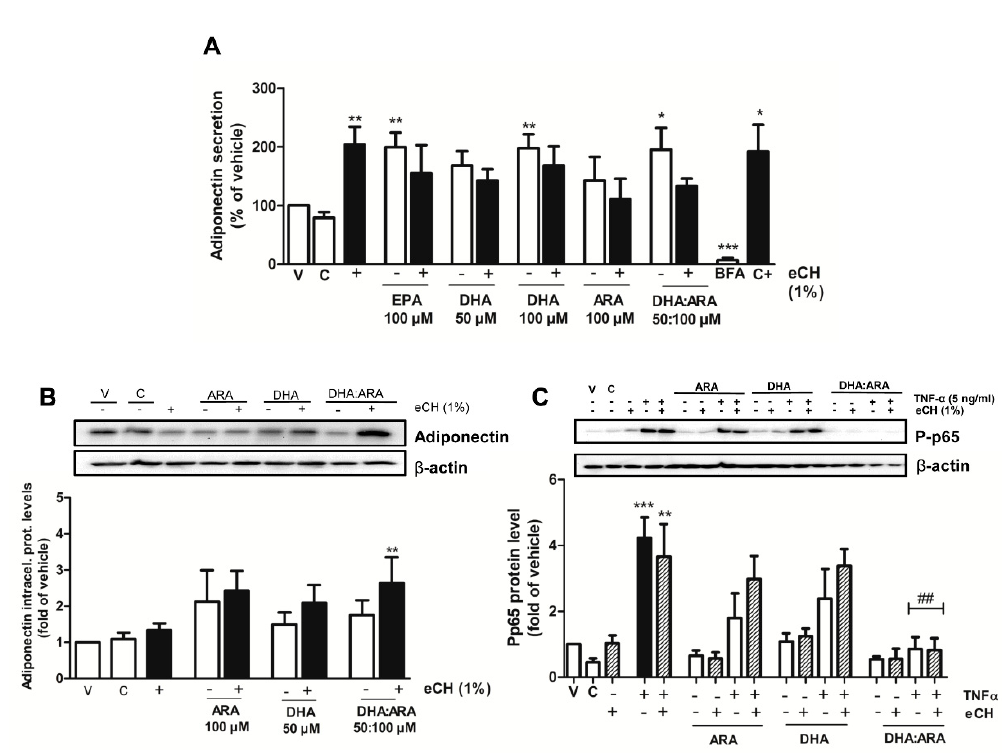
Figure 7. eCH does not potentiate the effect of n-3 LC-PUFAs on adiponectin secretion. ( A ) Effect of EPA (100 µM), DHA (50 and 100 µM), ARA (100 µM), and DHA/ARA (50 µM:100